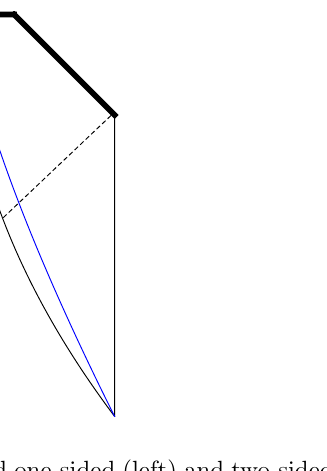
Figure 2 . Perturbed one-sided (left) and two-sided (right) AdS-RN black holes. The null parts are mass-in(cid:13)ation singularities. A spacelike piece of the singularity forms whenever caustics arise on a null singularity. Such caustics always arise in the one-sided case, and also occur for strong enough perturbations (as shown here) in the two-sided case. The resulting spacelike singularities should be Kasner-like, as can be seen from the fact that the region between the inner- and outer-horizons in (cid:12)gure 1 admits a foliation by spatially homogenous slices that, when subjected to correspondingly homogeneous perturbations, becomes precisely an AdS-Kasner solution. Su(cid:14)ciently close to a curvature singularity, one should be able to treat any solution as approximately homogeneous, so the spacelike part of the singularity should again be Kasner-like. In the left panel, the black hole is formed by a collapsing shell (in